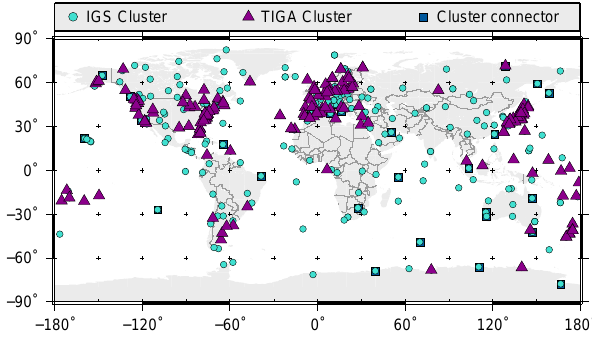
Fig. 1. Global distribution of TIGA and IGS tracking stations used for reprocessing.